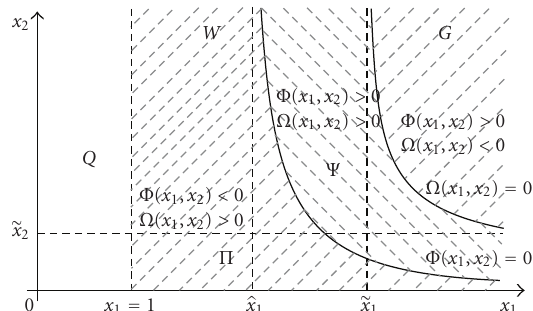
Figure 6: Signs of functions Φ ( x 1 , x 2 ), Ω ( x 1 , x 2 ) and sets Π , Ψ , and G .